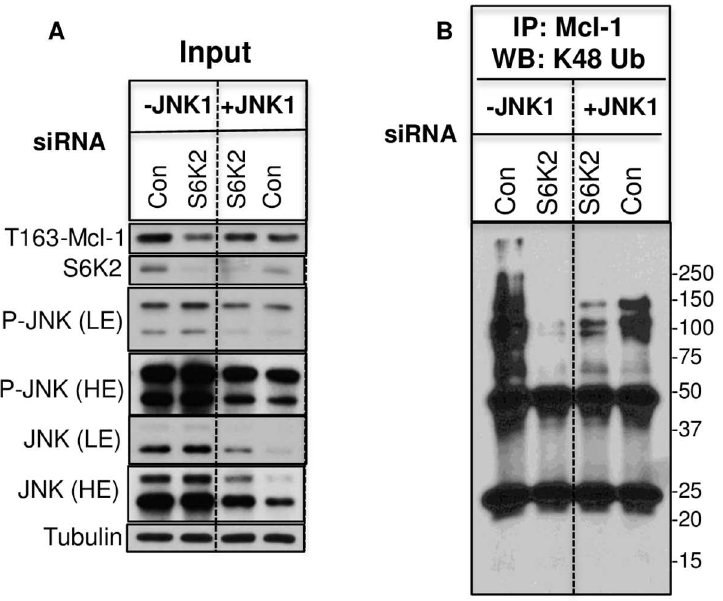
Fig 7. Effects of JNK1 and S6K2 knockdown on Mcl-1 phosphorylation and ubiquitination. Cells were treated with indicatedsiRNAs for 48 h and then treated with 10 μ M MG132 for 6 h. Cells were then processed for immunoprecipitation using Mcl-1 antibody as describedunder “Materials and Methods.” Both inputs and immunoprecipitateswere subjectedto Western blot analysisusing indicatedantibodies.